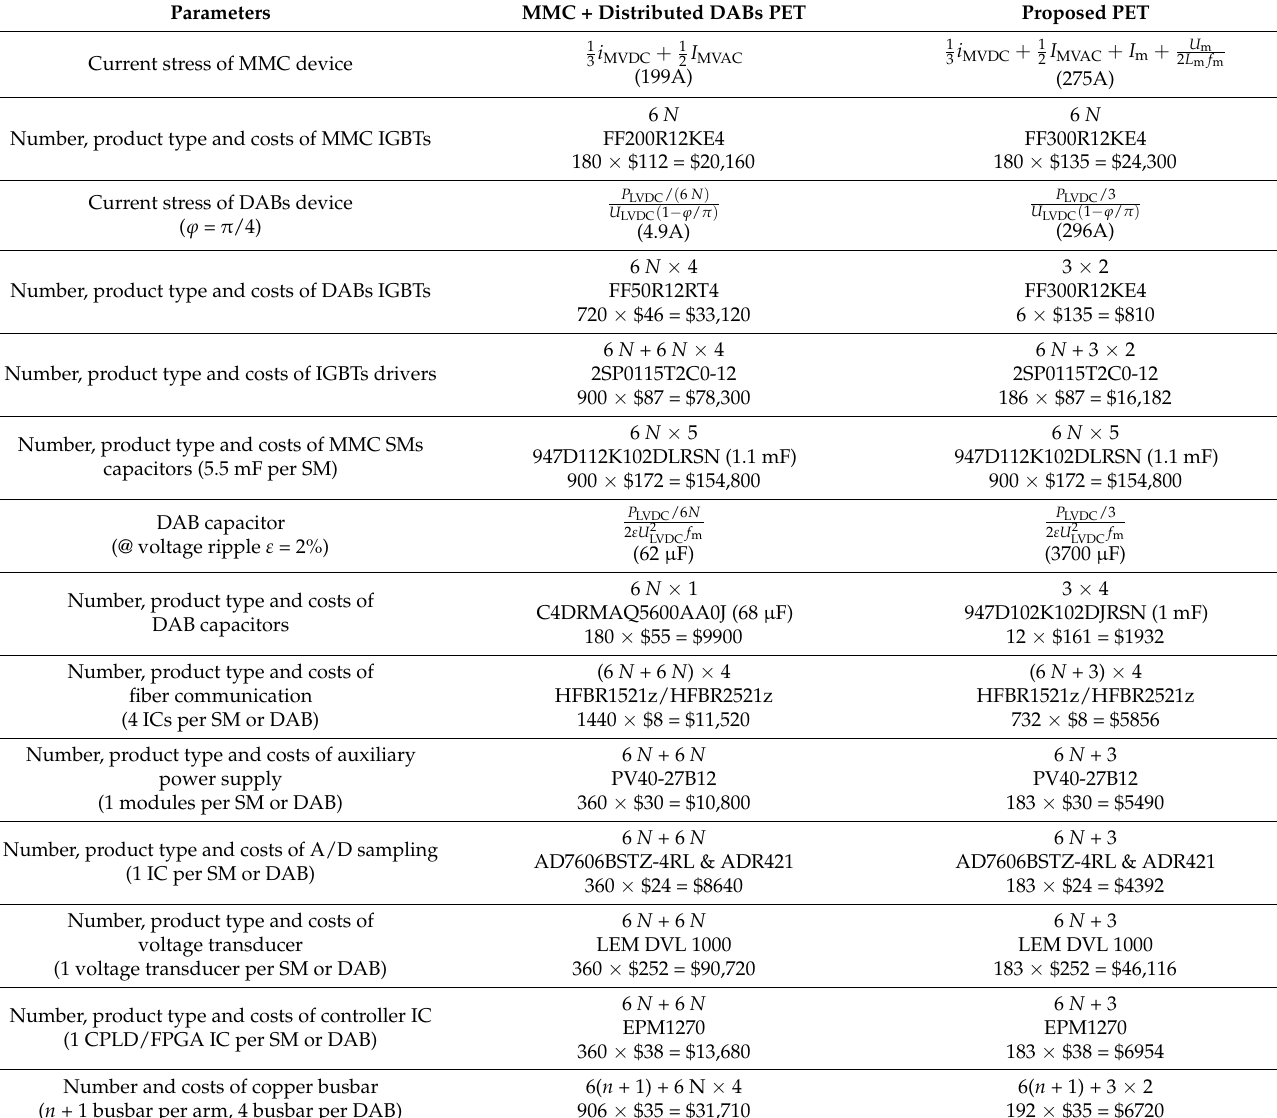
Table 3. Device cost comparison of proposed PET with existing typical